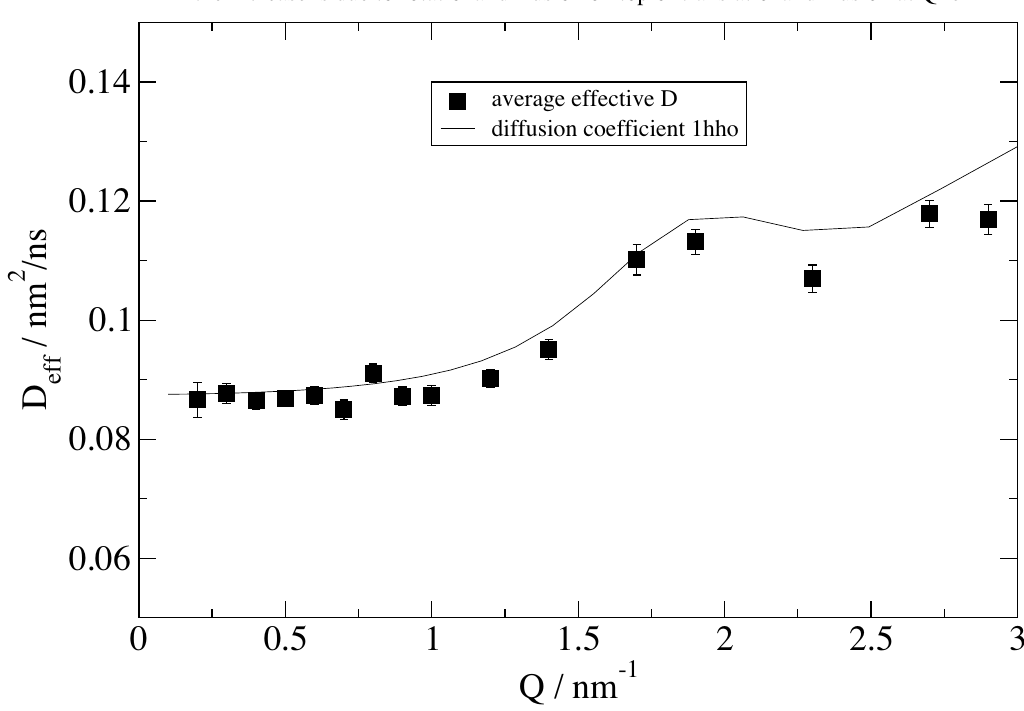
Fig 3. Result for the effective diffusion D eff (Q) together with the expectation according to a rigid protein structure. A common amplitude A was fitted. The upturn in diffusion is due to the additional effect of rotational diffusion if the scattering vector reaches the length scale of the protein (here hemoglobin)[5]. Axis legend and legends are inserted in Grace after